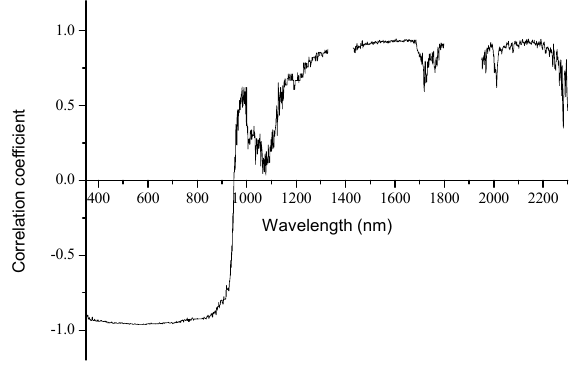
Figure 6. Correlation coefficient for the linear regression of spectral reflectance on the oil-polluted area fraction plotted against wavelength.